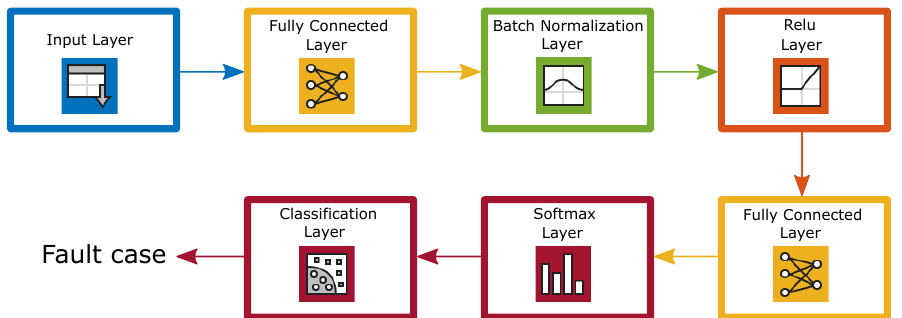
Figure 3. Block diagram of FNN used for fault